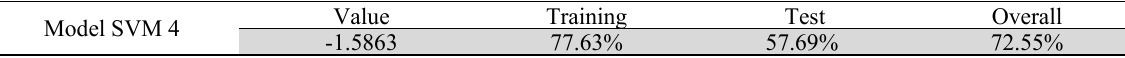
The results of SVM-4